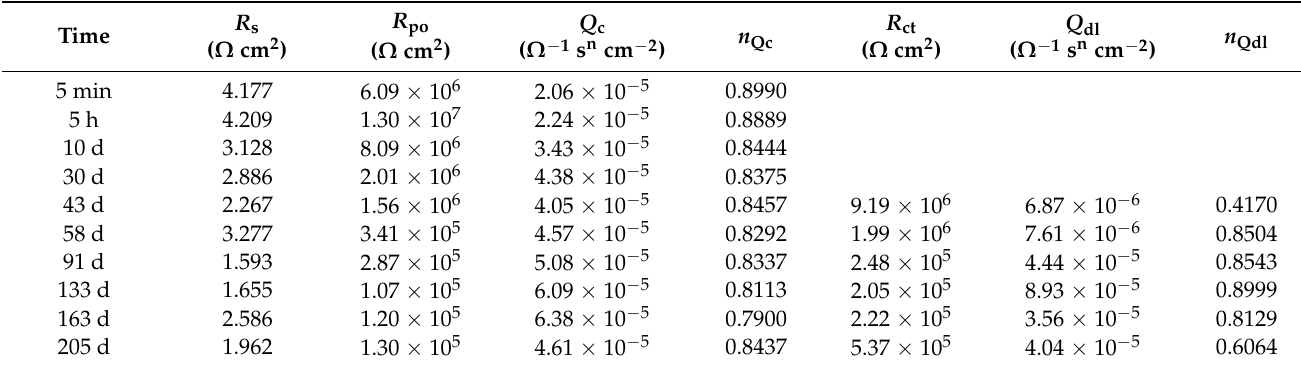
Figure 3. Equivalent circuit models used for EIS data fitting. ( a ) Model A; ( b ) Model B. Table 2. The impedance fitting parameters of the T700/VE composite.